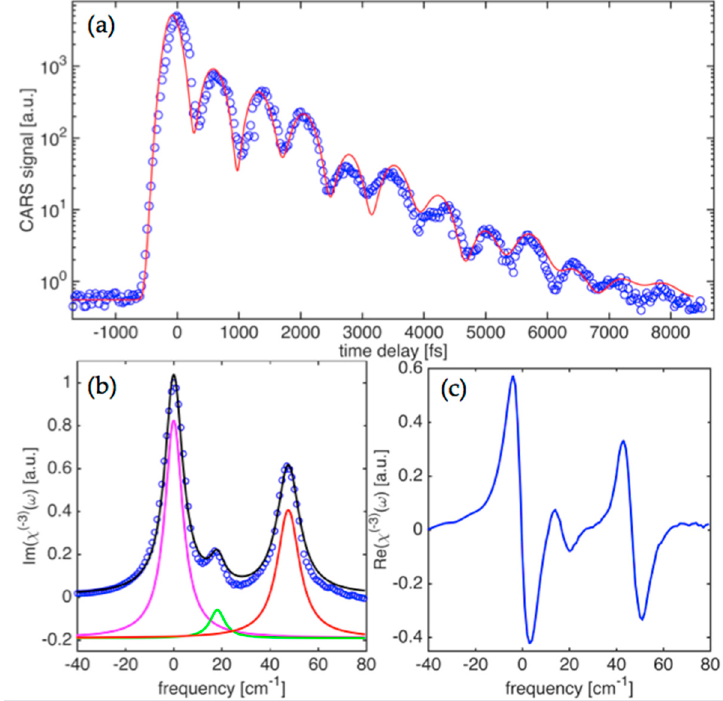
Figure 3. ( a ) CARS transients (open circles) obtained from KTP crystal when the OPO wavelengths were set to 967 nm and 1052 nm (~830 cm − 1 vibration). The solid line represents the theoretical fit that assumes three spectral components and is obtained using a software algorithm that varies multiple parameters for each component (amplitude, spectral position, dephasing time), assuming a Raman doublet with 62 cm − 1 frequency difference and decaying with the dephasing times of 950 fs and 1160 fs; ( b ) Corresponding spectrum of the resonant third-order nonlinearity ( χ (3) ( ω )) obtained using experimental CARS transient and applying Equation (5). The imaginary part of χ (3) is shown in blue open circles. The solid black line is the best fit to the spectrum assuming three components shown in separate colors and with parameters provided in the text; ( c ) The real part of χ (3) ( ω ).